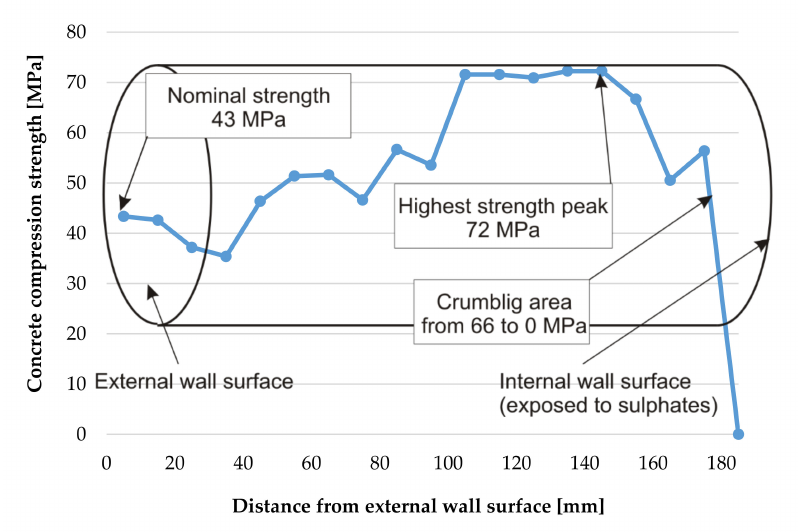
The dependencies of compressive strength as a function of depth for the borehole No. 1 are shown in Figure 8.